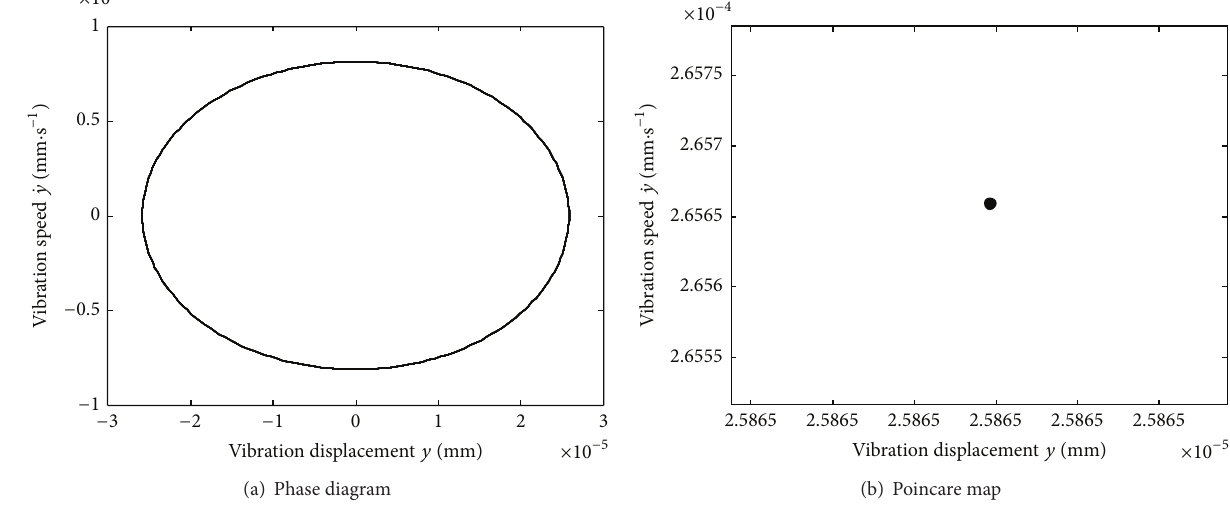
Figure 11: Periodic motion when 𝜎 = 50 Hz and 𝜀𝐹 = 0.529 MN.